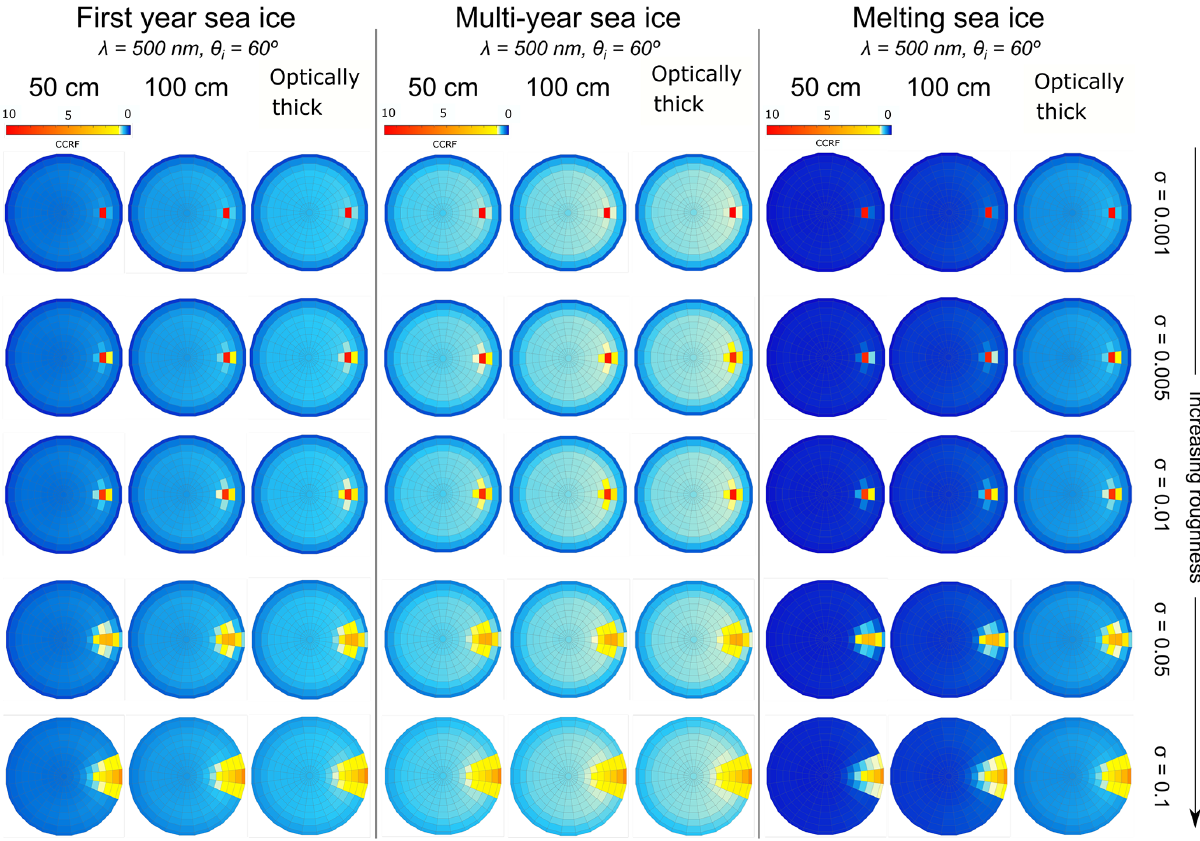
Figure 6. CCRF of 50cm, 100cm and optically thick first-year sea ice, multi-year sea ice and melting sea ice with an increasing surface roughness. The incident angle is θ i = 60 ◦ , and the results are reported for λ =